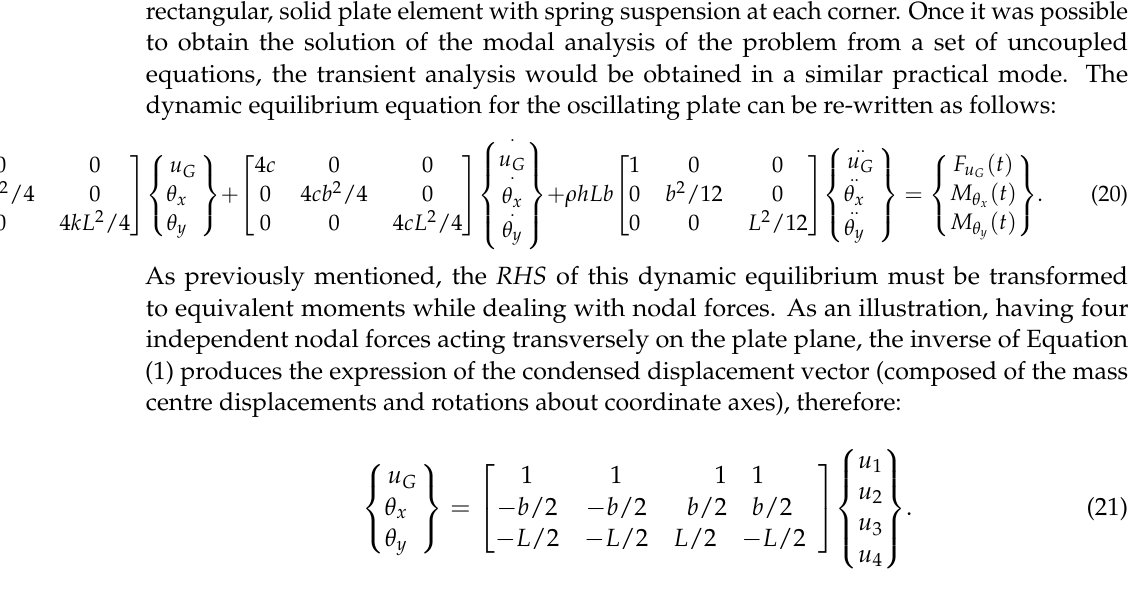
Table 3. Analytical natural frequency solutions. Natural Frequency, f (Hz) Motion Description = 1.06 Rotation around Y G axis; f ANL 1 Vertical motion, vertical translation of the plate, four springs = 1.25 f ANL 2 simultaneously in function; = 2.00 Rotation over X G f ANL 3